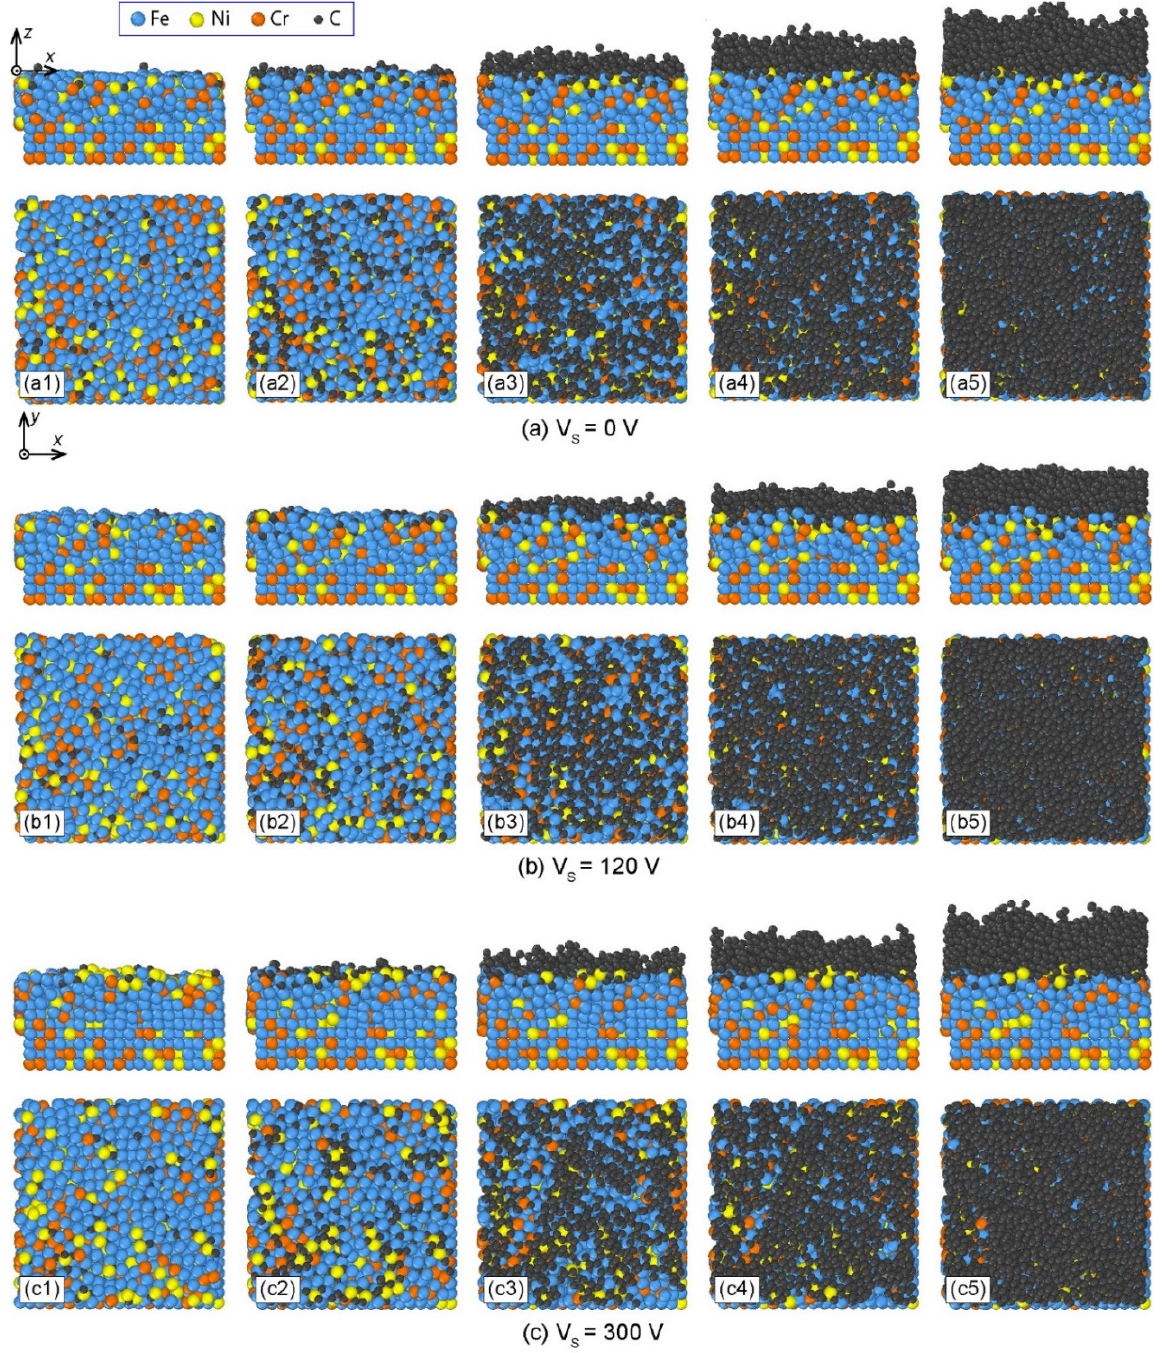
Figure 2. Deposition processes of carbon thin films on AISI 316 stainless steel substrates under different substrate bias voltages: ( a ) Vs = 0 V, ( b ) Vs = 120 V, and ( c ) Vs = 300 V.